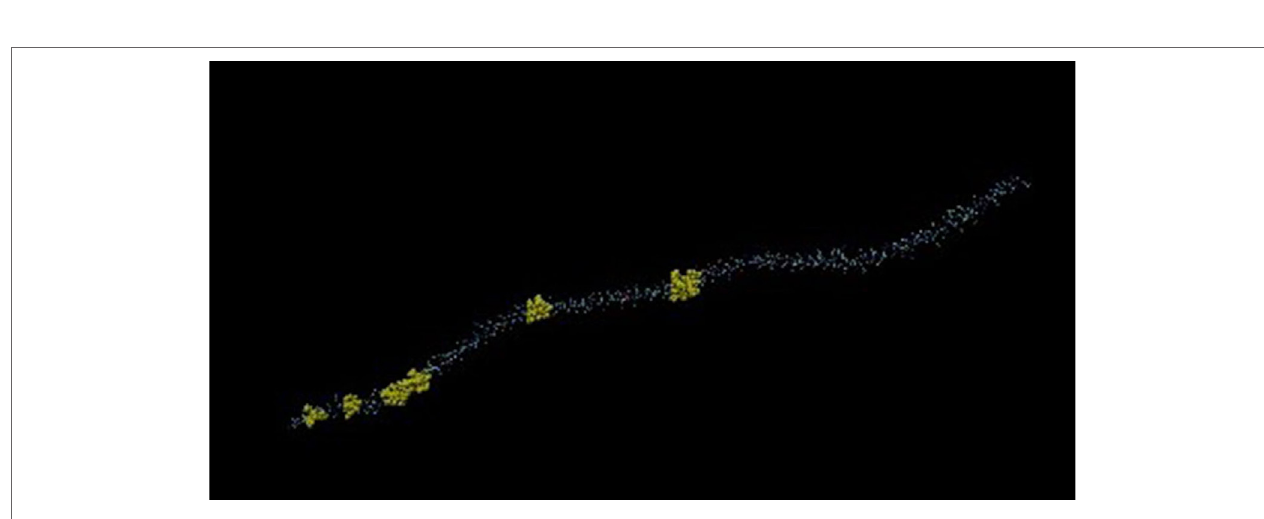
FigUre 8 | Three-dimensional structure of Probable ATP-dependent clp protease ATP-binding subunit of Mycobacterium leprae